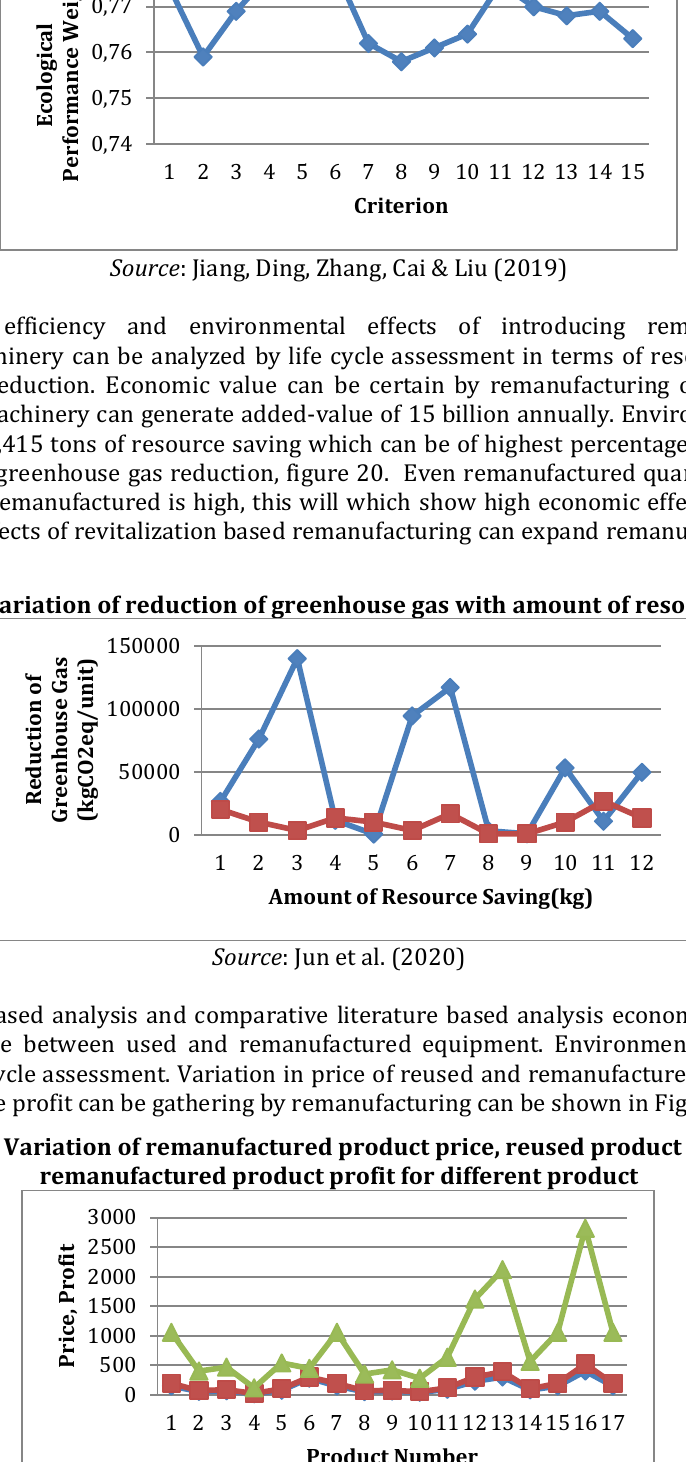
Blue: reused product price, Red: remanufactured product price, Green: remanufactured product profit Source : Jun et al. (2020)